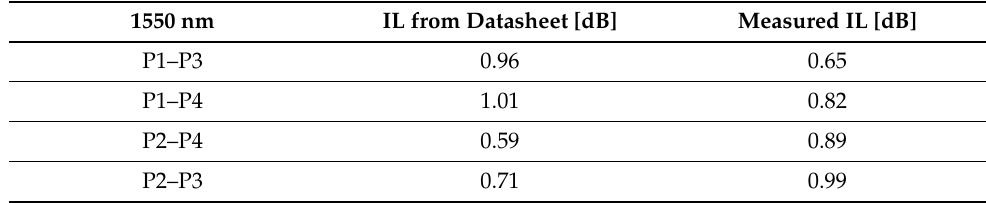
Table 10. Insertion loss of optomechanical